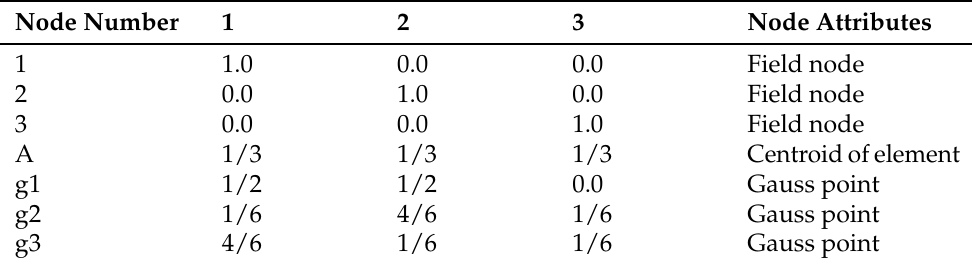
Figure 3. Illustration of the interpolation distribution of the Gaussian integration points of the ES-FEM shape function. Table 1. The shape function entries at different points on the boundary of the smoothing domain connected to the outer edge 1–2 in Figure 3.